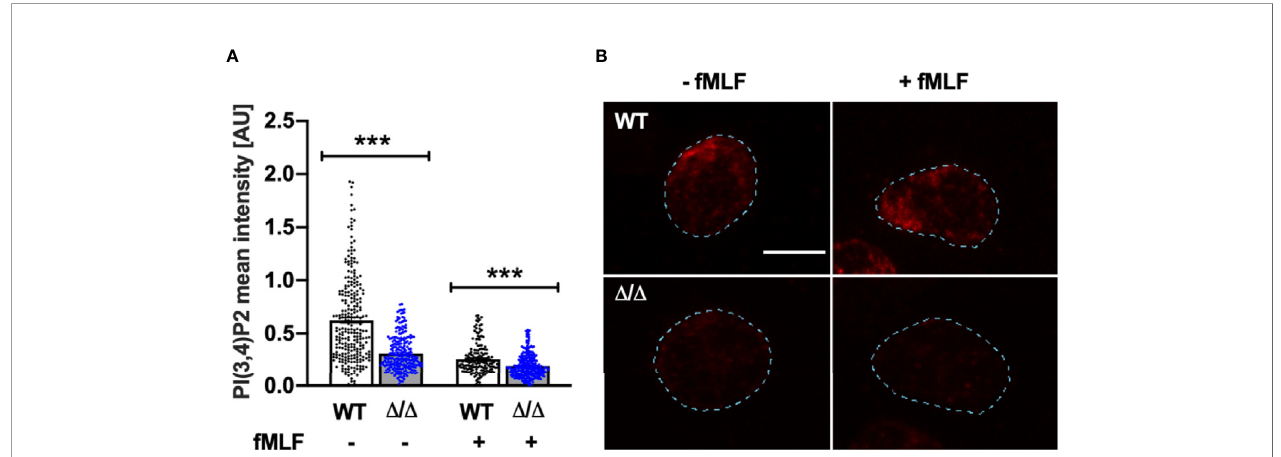
FIGURE 7 | Ship2 D / D neutrophils contain less PI(3,4)P2 than controls. Bone marrow-derived wild-type (WT) and Ship2 D / D ( D / D ) neutrophils were plated onto glass coverslips in the presence or absence of 1 m M fMLF for 5 minutes prior to being fi xed and subjected to immunostaining with an anti-PI(3,4)P2 antibody. (A) PI(3,4)P2 signal intensity was analyzed automatedly using CellPro fi ler as detailed in Materials and Methods. The graph presented combines cells from 3 separate experiments for a minimum of 176 cells per condition and data were analyzed with the Mann-Whitney test. *** p < 0.001. (B) Representative examples of PI(3,4)P2-stained neutrophils for each condition. For ease of viewing, the outline of the cells shown here was traced using FiJi (broken lines). Scale bar, 5 m